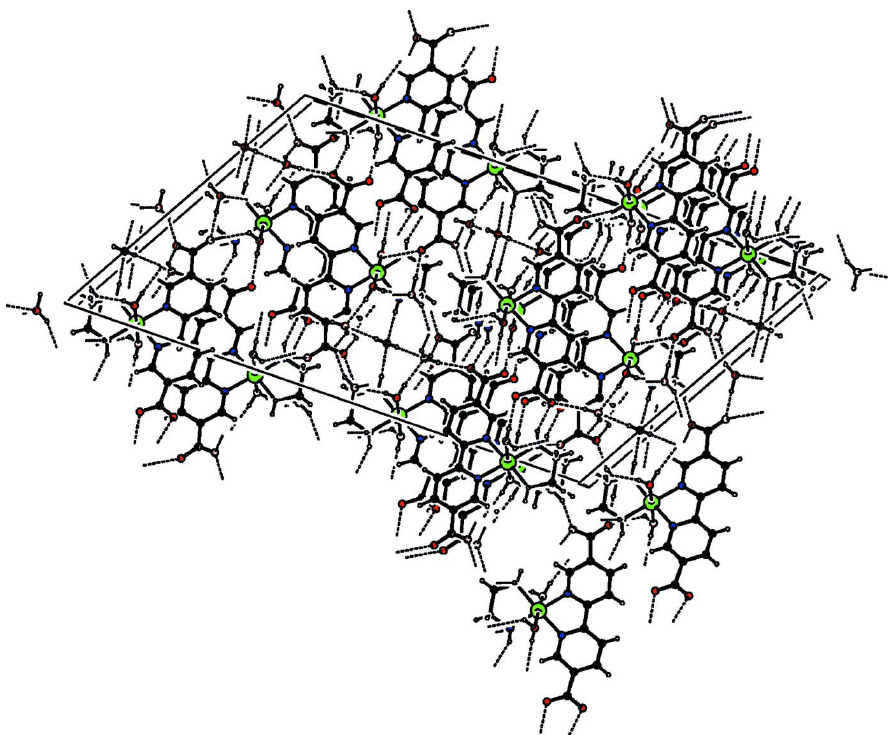
Figure 2 A packing diagram of the title compound. Hydrogen bonds are shown as dashed